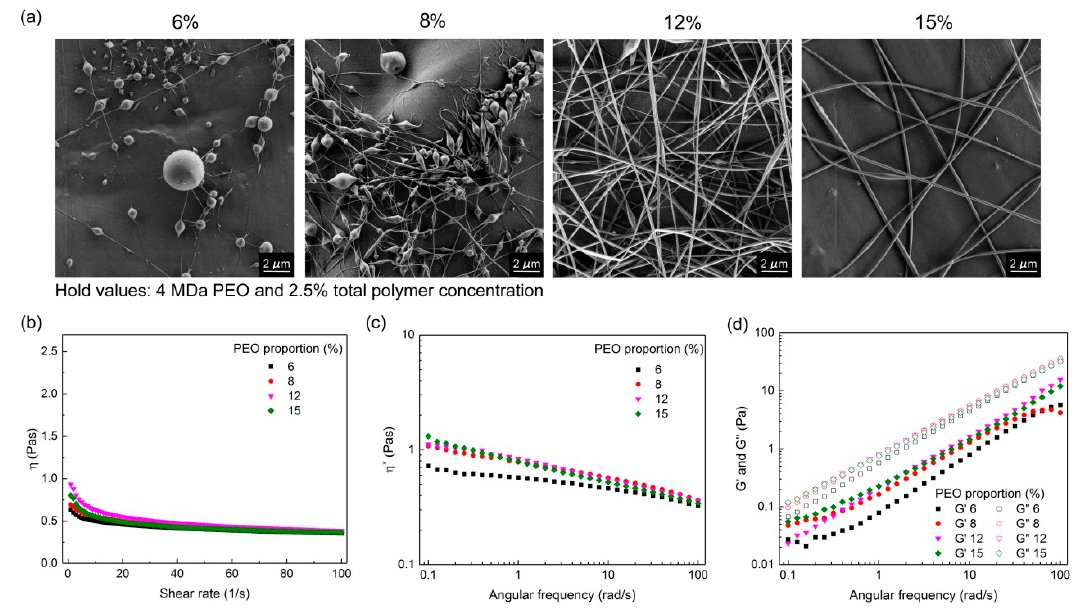
Figure 5. ( a ) scanning electron microscopy images of nanofibers obtained from polymer-blend solutions formed with different PEO proportions in the dry polymer mix (as indicated), with 4 MDa PEO and 2.5% total polymer concentration; ( b – d ) corresponding viscosities ( η ) ( b ); complex viscosities ( η * ) ( c ), and storage ( G’ ) and loss ( G” ) moduli ( d ).